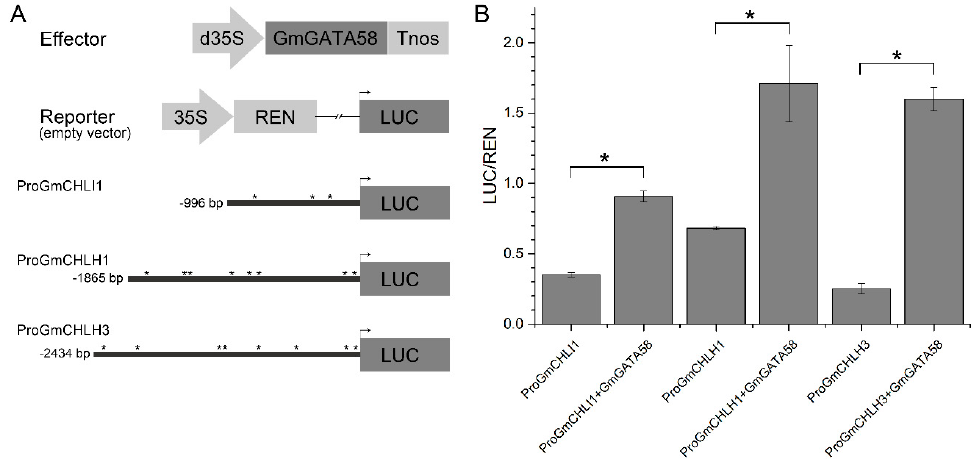
Figure 7. Dual-luciferase reporter assays of GmGATA58 and three promoters of chlorophyll biosynthetic genes ( GmCHLI1 , GmCHLH1 and GmCHLH3 ) from soybean in transiently transformed protoplast of Arabidopsis. ( A ) Schematics of effector and reporter constructs for dual-luciferase reporter assay. d35S, double CaMV 35S promoter; Tnos, NOS terminator; REN, Renilla luciferase;